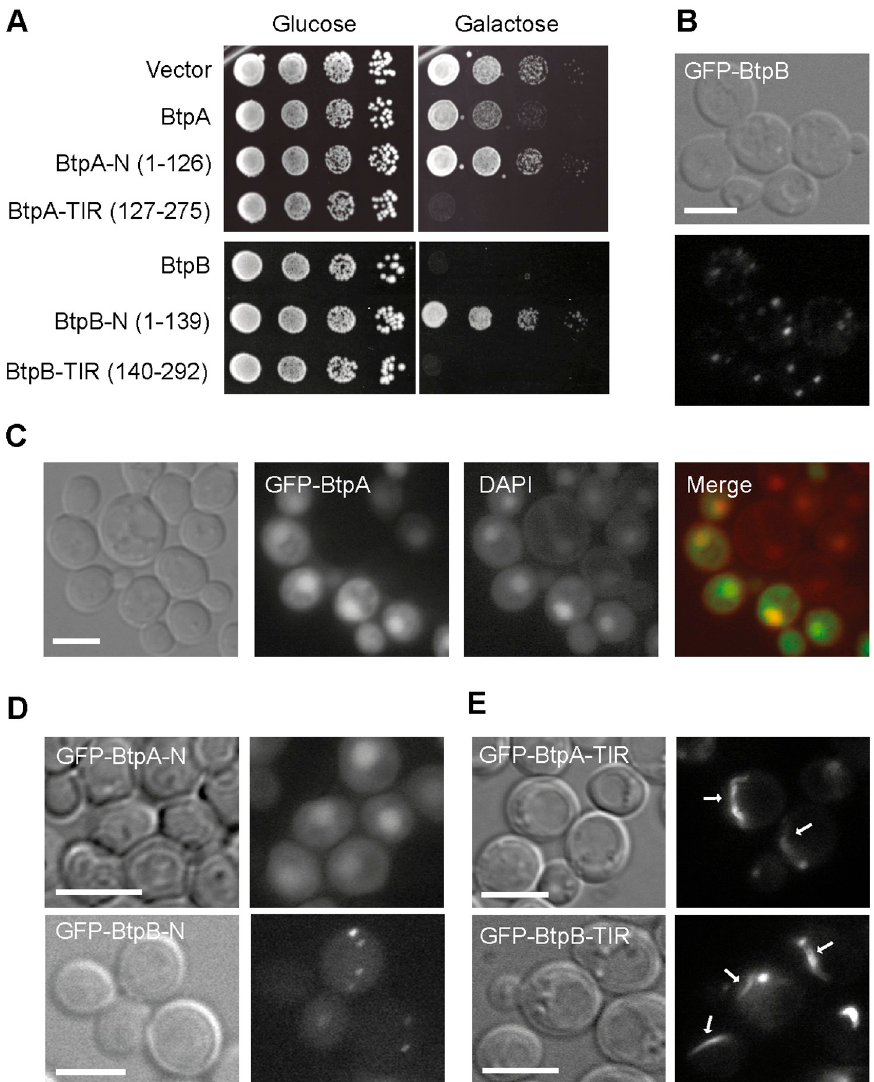
Fig 1. Expression and localization of B . abortus BtpA and BtpB in S . cerevisiae . (A) BtpA and BtpB induce different levels of toxicity when expressed in yeast. Ten-fold serial dilution assay to monitor growth in YPH499 yeast strain expressing the pYES2 empty vector or the BtpA or BtpB indicated versions (full-length, N and TIR) from pYES2-GFP plasmid derivatives, under control (Glucose) and induction (Galactose) conditions. Nomarski and fluorescence microscopy of YPH499 yeast strain expressing from pYES2 plasmid derivatives the following fusion proteins: (B) full- length GFP-BtpB after 4h induction; (C) full-length GFP-BtpA (green) and stained with DAPI (red), after 6h induction; (D) the GFP-fused N-terminal regions of BtpA and BtpB after 5h induction; (E) the GFP-fused C-terminal regions containing TIR domains of BtpA and BtpB after 4h induction. Scale bars correspond to 5 μ